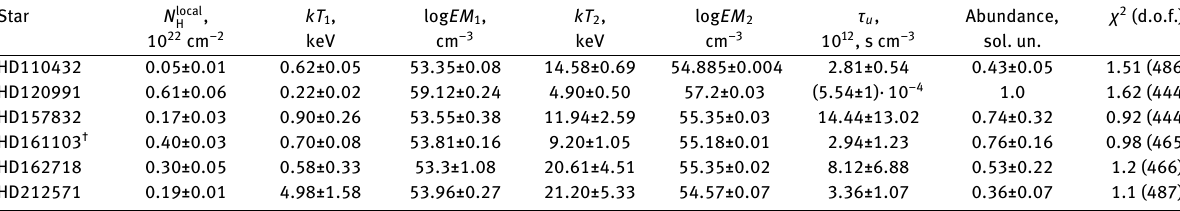
Table 5. The same as in Table 3 but for PSHOCK+PSHOCK models. Star